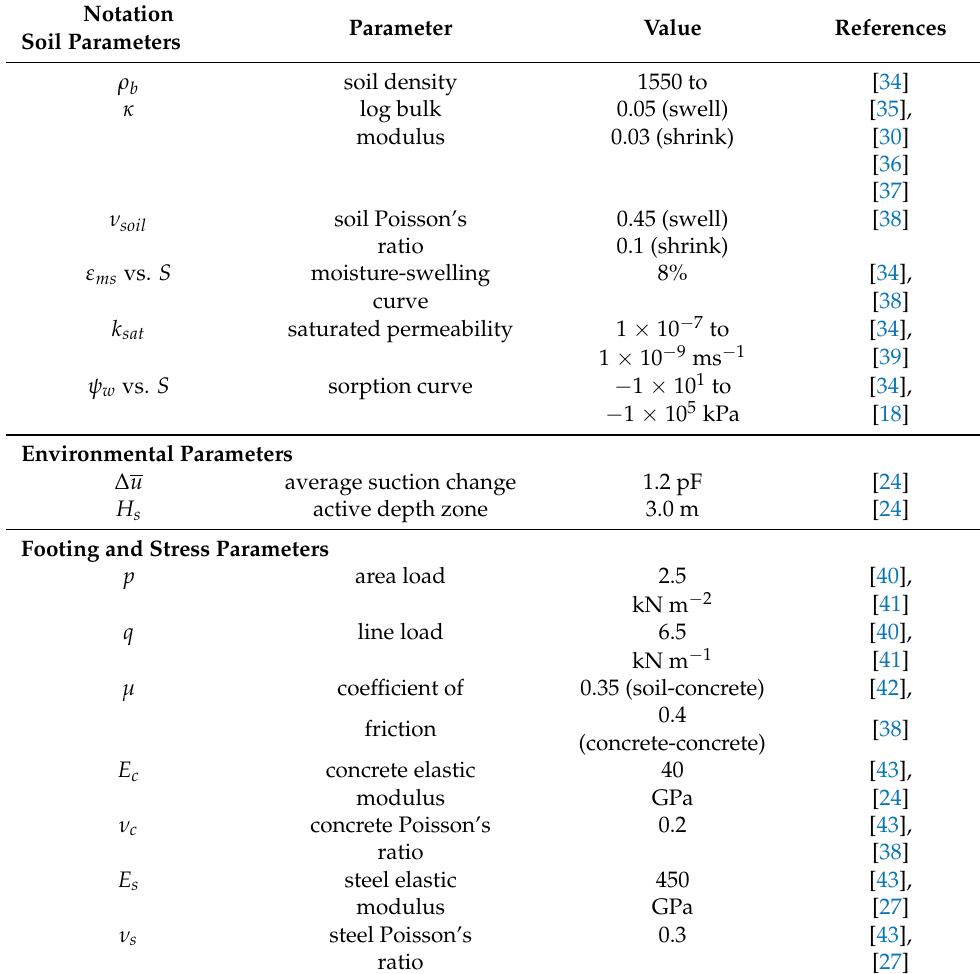
Table 3. Parameter inputs for the numerical simulations of prefabricated footings and waffle rafts related to soil state, environmental factors, footing dimensions and stress